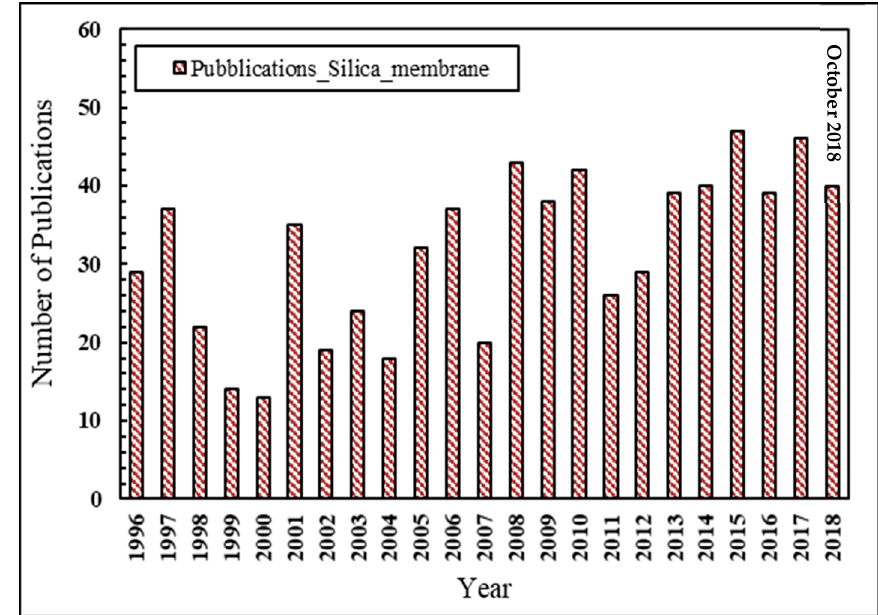
Figure 2. Number of scientific publications about silica membranes for hydrogen separation vs. year, Scopus database: www.scopus.com.